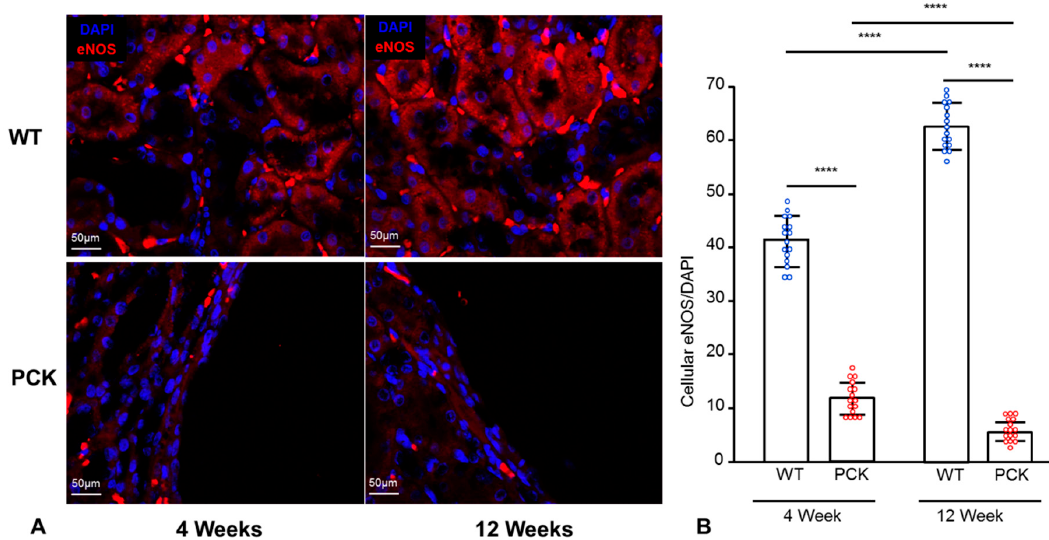
Figure 6. Renal eNOS immunoreactivity is downregulated in PKD. Representative IF staining for eNOS (red) in WT and PCK rats at 4 and 12 weeks ( A ) and its quantification ( B ) showing decreased eNOS immunoreactivity in PCK animals at 4 weeks, which further decreased at 12 weeks. **** p < 0.000; eNOS was quantified as % stained area and adjusted to DAPI-stained % area; (n = 16 / group) Peritubular capillary index, assessed by peritubular capillary count in hematoxylin–eosin (H&E) stained slides and adjusted by cystic area, was not different in the cortex or medulla in PCK vs. WT rats at 4 weeks of age, but it was lower in the cortex and medulla at 12 weeks (Figure 7 and Table 2) and inversely correlated with the cystic index (Supplementary Figure 8).